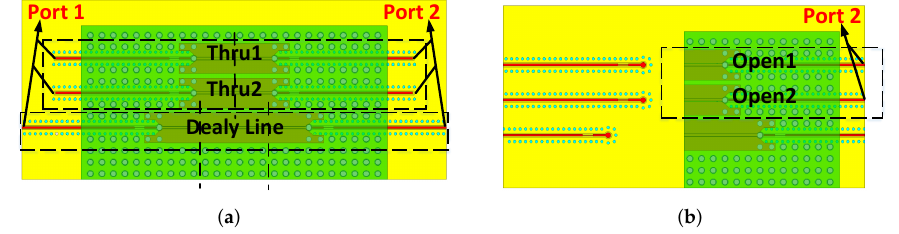
Figure 9. Simulation models of the thru/delay line/reflect structure. ( a ) Thru, delay line structure. ( b ) Reflect